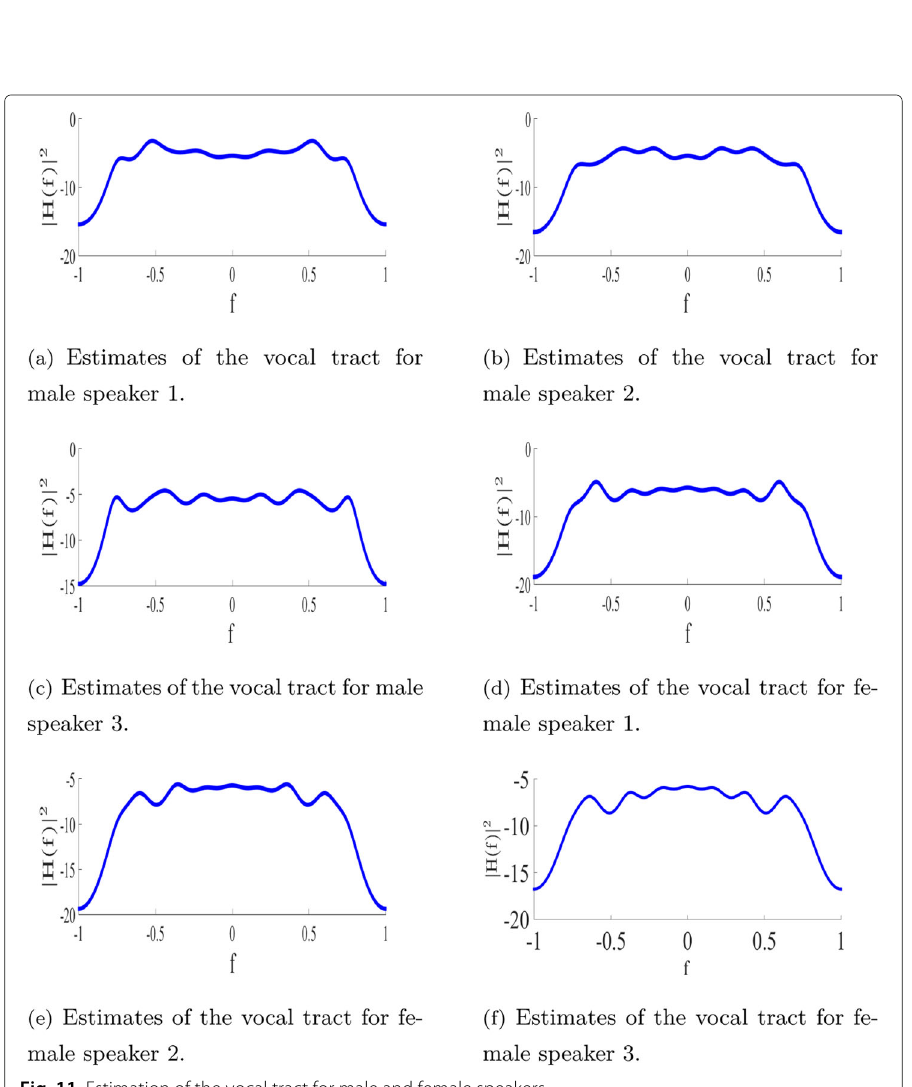
Fig. 11 Estimation of the vocal tract for male and female